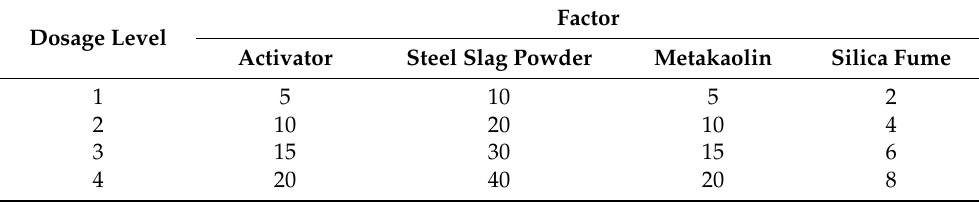
Table 3. Level details of factors (wt